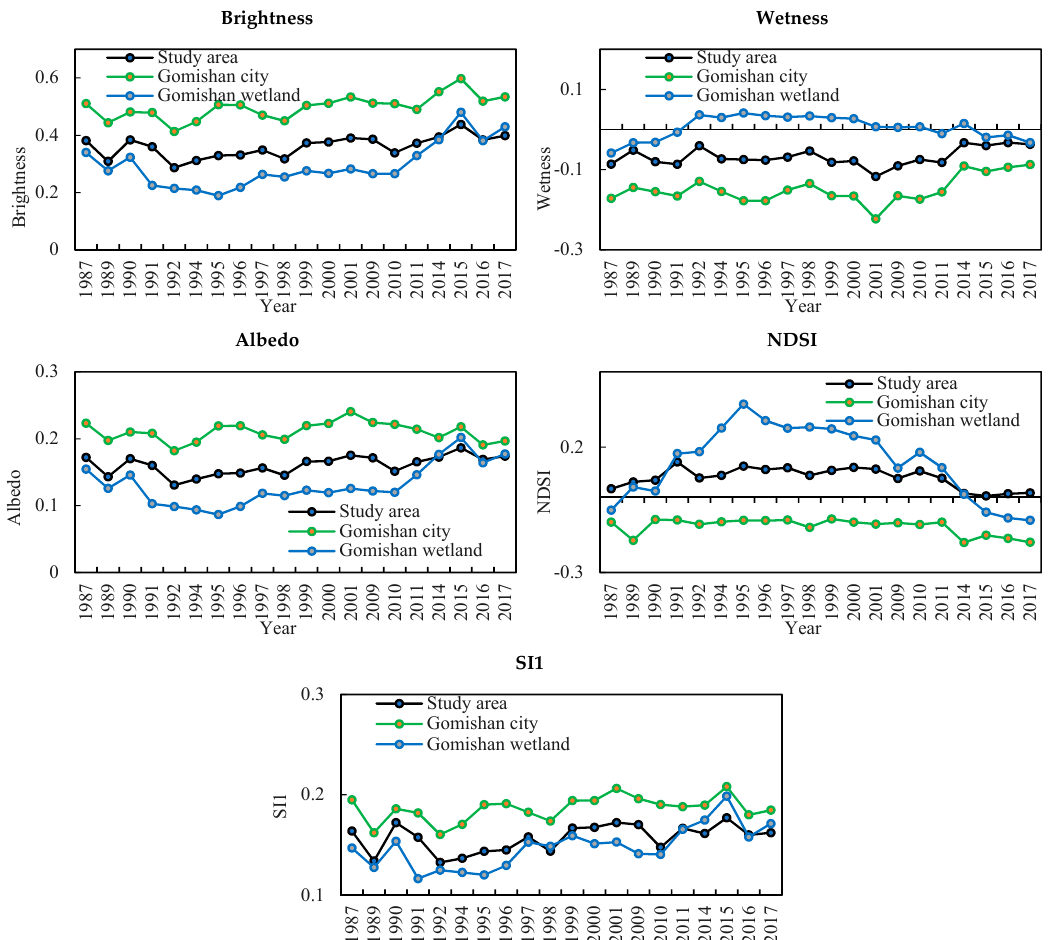
Figure 9. Mean of surface biophysical characteristics for the Gomishan wetland, Gomishan city, and study area using Landsat imagery.